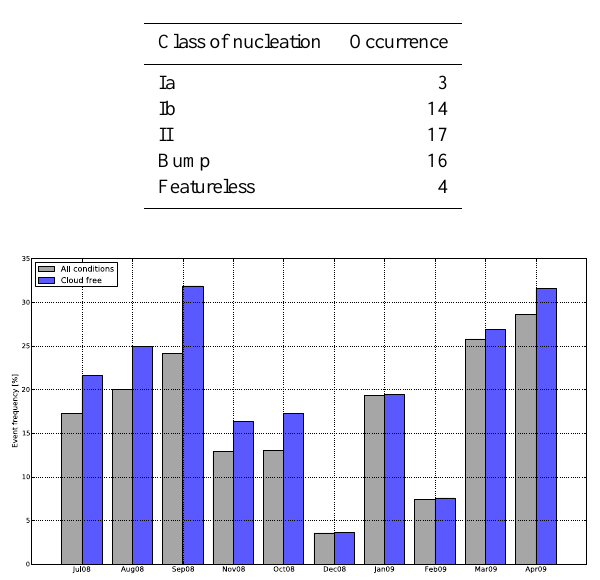
Table 1. Statistics of nucleation events.